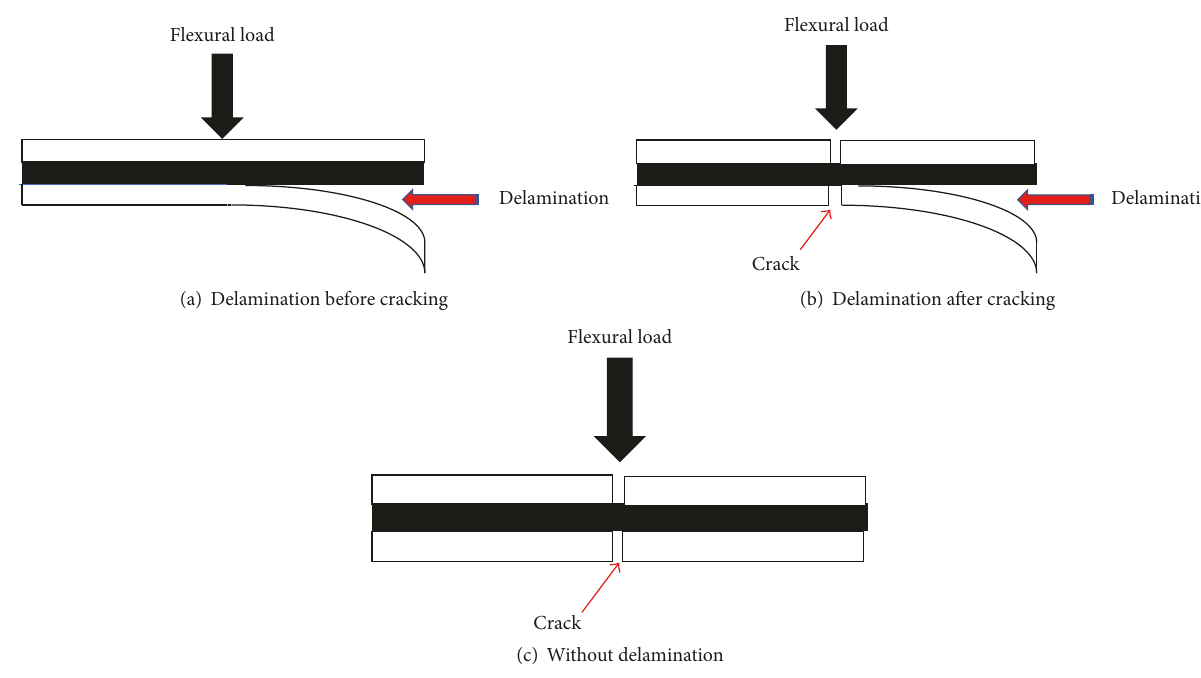
Figure 8: Fracture mode after flexural tests.